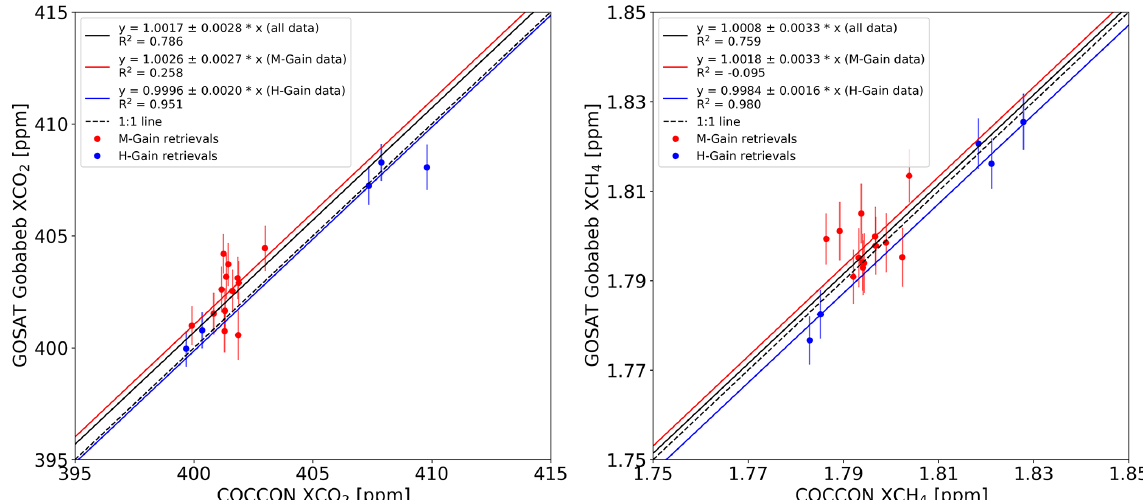
Figure 12. Correlation plots between coincident COCCON Gobabeb observations and GOSAT measurements over the COCCON site be- tween 2016 and 2019. For this area, GOSAT performed M-gain (red dots) and H-gain (blue dots) soundings. The solid red line is the best-fit line through all M-gain data points, the solid blue line is the best-fit line through all H-gain data points and the solid black line is the best-fit line through all data points. The dotted black line is the 1:1 line. Error bars denote the 1 σ standard deviation of the hourly mean values for COCCON measurements and the measurement error for the GOSAT soundings.